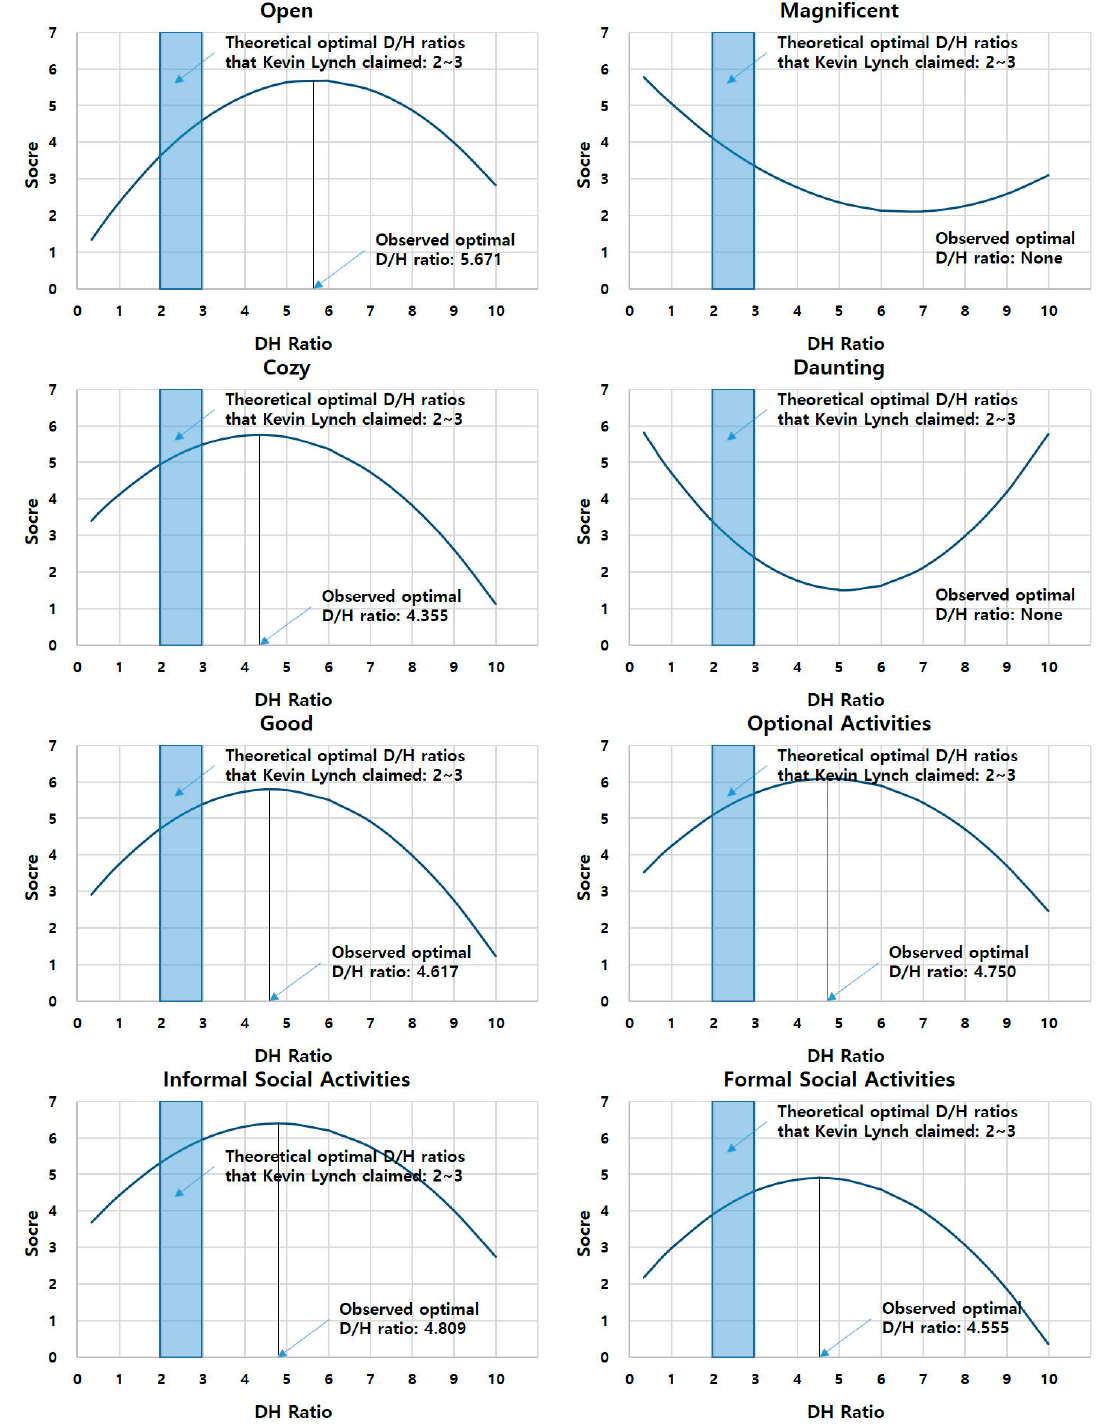
Figure 4. The relationship between D/H ratios and the eight dependent variables.